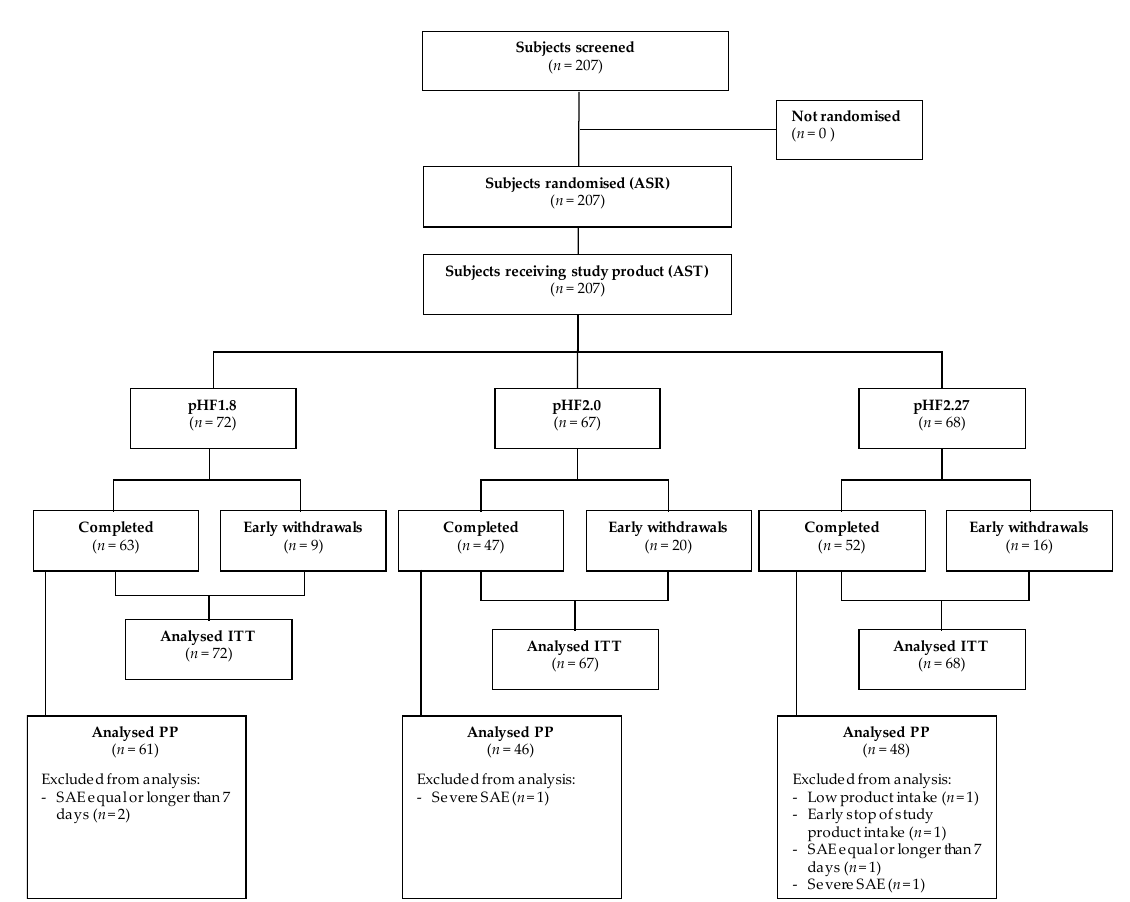
Figure 1. Flow Diagram. pHF, partially hydrolysed formula; PP, Per Protocol; ITT, Intention-To-Treat.